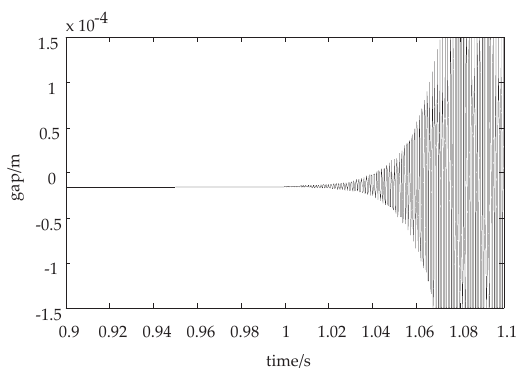
Figure 4. The suspension displacement curve while the load mass changes and the control parameters remain the same.